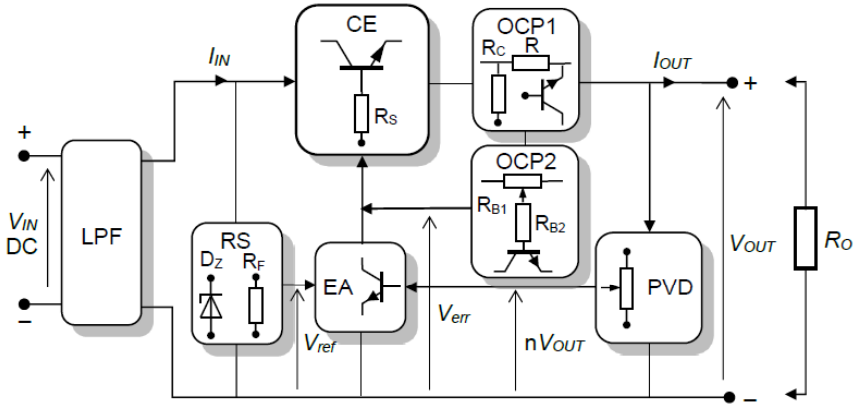
Figure 5. Block diagram of the proposed PVE.